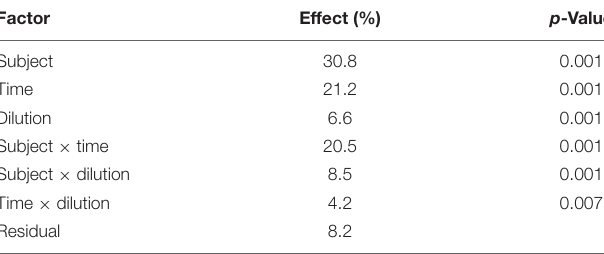
TABLE 1 | Results obtained from ASCA applied on the fused dataset of microbiome and volatilome